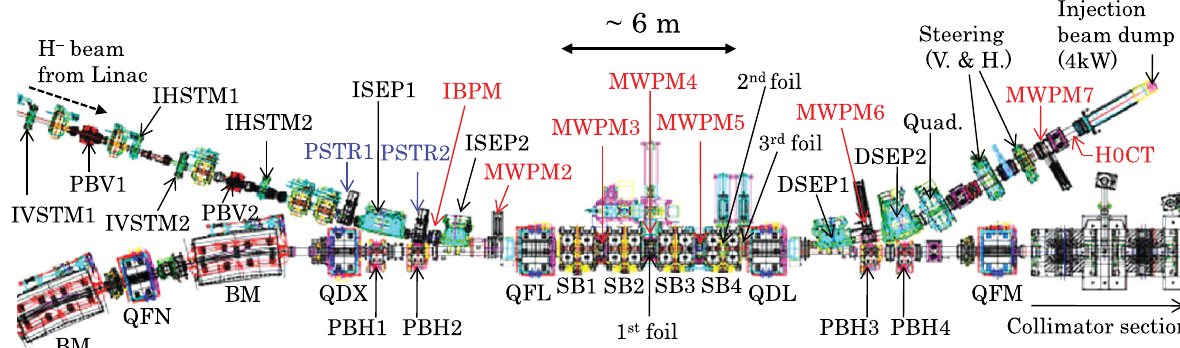
FIG. 3. Layout of RCS injection area. In order to switch transverse painting area MLF to MR in the horizontal direction, two PSTR magnets are recently installed in the L-3BT line as shown by blue arrows. The phase space coordinates of the injected beam at the first stripper foil in controlled pulse to pulse for that purpose. Four chicane bump magnets are named SB1-4, while four horizontal and two vertical painting bump magnets are named PBH1-4 and PBV1-2, respectively. The PBV1-2 are located in the L-3BT line and thus painting area in the vertical direction is also changed in a pulse to pulse. More than 99.6% of incoming H (cid:2) beam from the linac is stripped to H þ by the first foil so as to inject into the ring